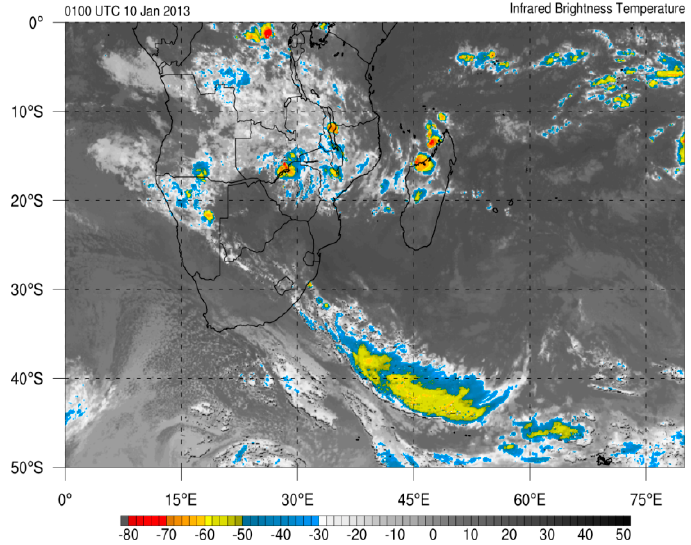
Figure 1. Infrared brightness temperature ( ◦ C) over southern Africa on 10 January 2013. (http: Figure 1 . Infrared brightness temperature (°C) over southern Africa on 10 January 2013. // www.atmos.albany.edu / student / papin / mapdisco / 20130201 / images / ir_africa.html). (http://www.atmos.albany.edu/student/papin/mapdisco/20130201/images/ir_africa.html). Precipitation variability over the subcontinent in the later summer of 2013 is also highlighted in various studies in literature. For example, the World Meteorological Organization (WMO) report of 2015 indicate heavy rainfall and floods recorded in January, particularly Mozambique which ranked amongst the 10 most severe flooding events globally (Table 1). In some places, the heavy rains led to extreme river flows, leading to severe floods in towns, farm / agricultural loss, loss of life and destruction of economic and social infrastructure [41]. According to the authors, ‘during January 2013, very heavy rainfall over central and southern Mozambique led to severe flooding with more than 100 deaths, and the displacement of about 200,000 people.’ Heavy and above average precipitation totals were also reported in other parts of the world. For example, the Global Climate Report of 2013 (https: // www.ncdc.noaa.gov / sotc / global / 201313) indicate that a tropical low caused major flooding along much of the eastern coast of Queensland and northern new South Wales in Australia; the Burnett river catchment had the most severe flooding and received nearly 70% of rainfall above the previous record, and many residential areas inundated. Floods hit various regions across Africa, with Mozambique experiencing severe flooding during January 12–31. Table 1 also highlights how the region was impacted by these heavy